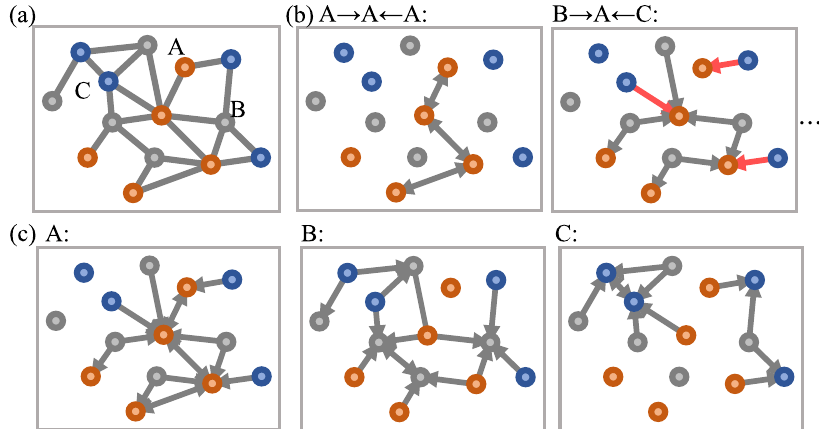
Fig. 1 A schematic diagram that demonstrates how to extract subgraphs from a original heterogeneous graph. a The original graph constructed via a certain method with multiple node types, speci fi cally, three types A, B, and C here. b Subgraphs extracted from the original , where N e is the number of node types. c Subgraphs graph according to triadic relations. The number of subgraphs is of the order of N 3 e extracted from the original graph according to type of central nodes. In this case, the number of subgraphs linearly increases with respect to N e